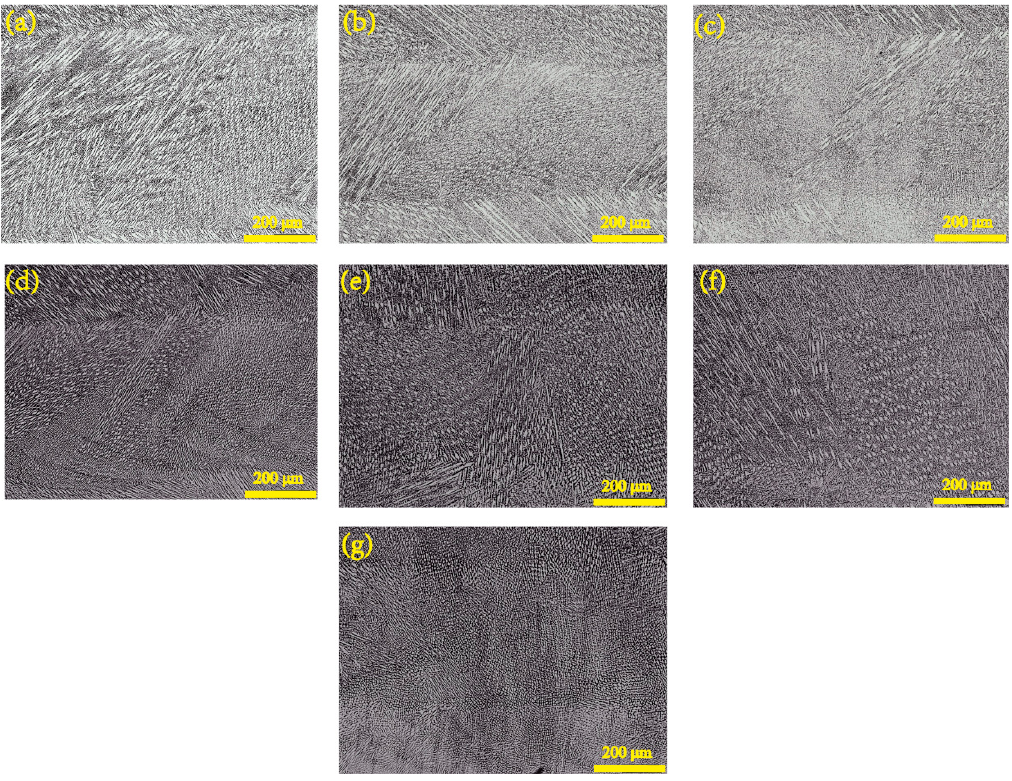
Figure 4. Optical micrograph of deposited specimens on various specific energy density. ( a ) 2752.3 J / g;